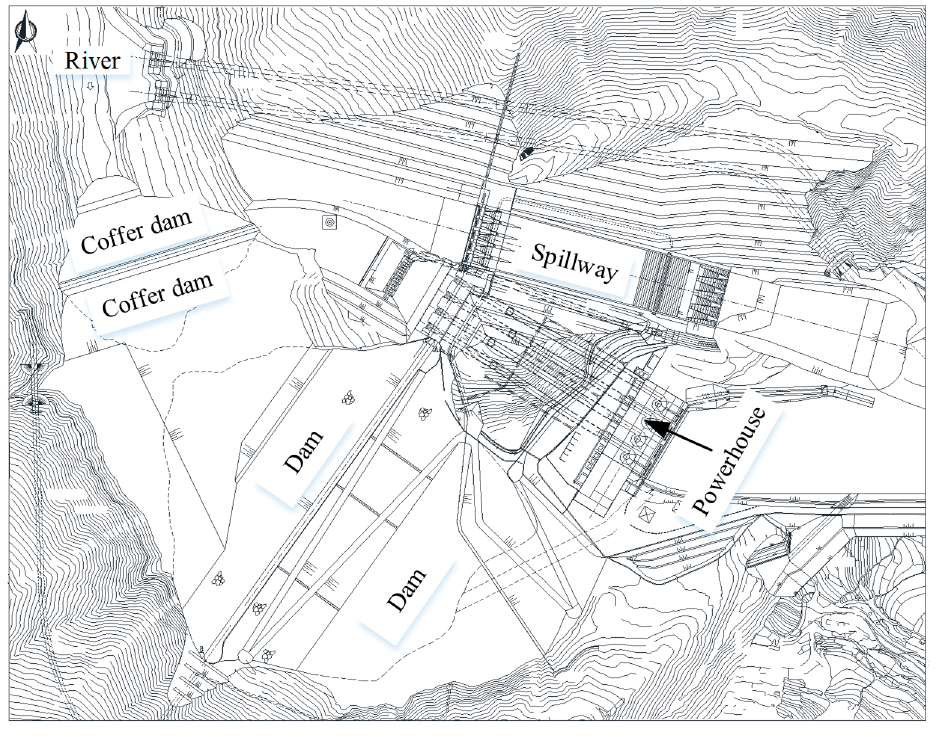
Figure 6. Curtain-grouting construction area and unit. 5.2. Determining Evaluation Indicators and Criteria The curtain-grouting efficiency was divided into five levels, which were excellent, good, ordinary, poor, and bad. The classification criteria of the grouting-efficiency evaluation indicators are shown in Table 1.